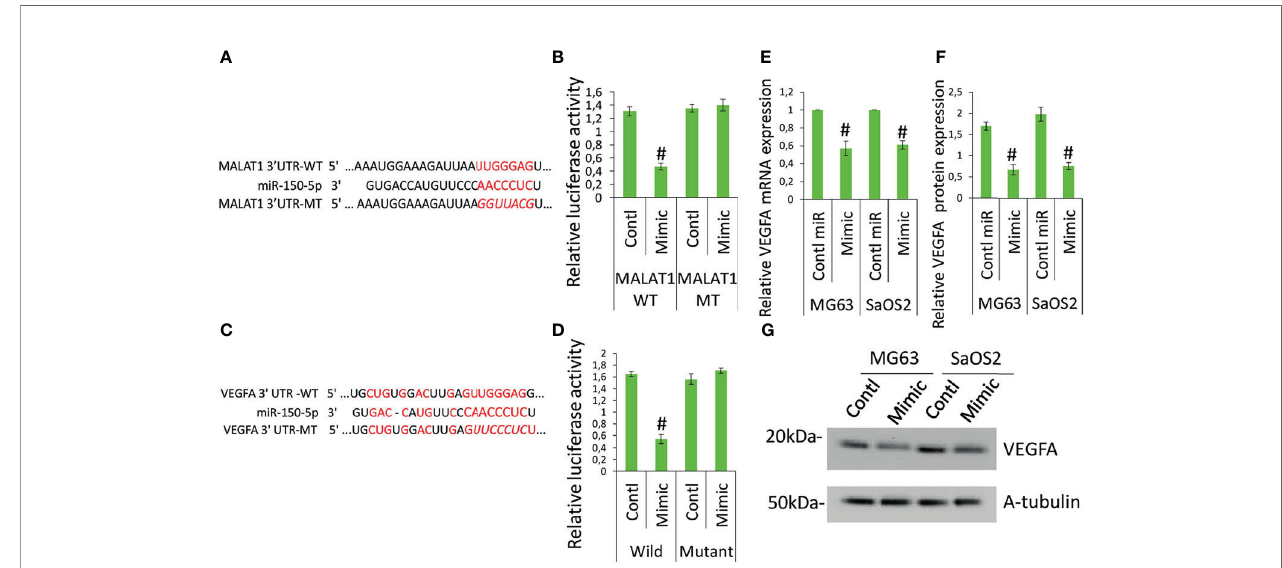
FIGURE 4 | MALAT1 targets miR-150-5p and miR-150-5p targets VEGFA in OS. MALAT1 directly targets miR-150-5p in OS. (A) The interactions between MALAT1 and miR-150-5p were predicted. (B) Dual-luciferase reporter assays were performed in MG63 and SaOS2 cells after cotransfection MALAT1 3 ′ -UTR wild/ mutant with miR-150-5p mimic or control miR. Number sign indicates signi fi cant decrease compared with other form of cotransfection. Similarly, (C) the interactions between miR-150-5p and VEGFA were predicted. (D) Dual-luciferase reporter assays were performed in MG63 and SaOS2 cells after cotransfection VEGFA 3 ′ -UTR wild/mutant with miR-150-5p mimic or control miR. Number sign indicates signi fi cant decrease compared with other form of cotransfection. miR-150-5p effects on VEGFA expression in OS was analyzed by transfecting miR-150-5p mimic or control miR in MG63 and SaOS2 cells. miR-150-5p mimic suppressed VEGFA mRNA